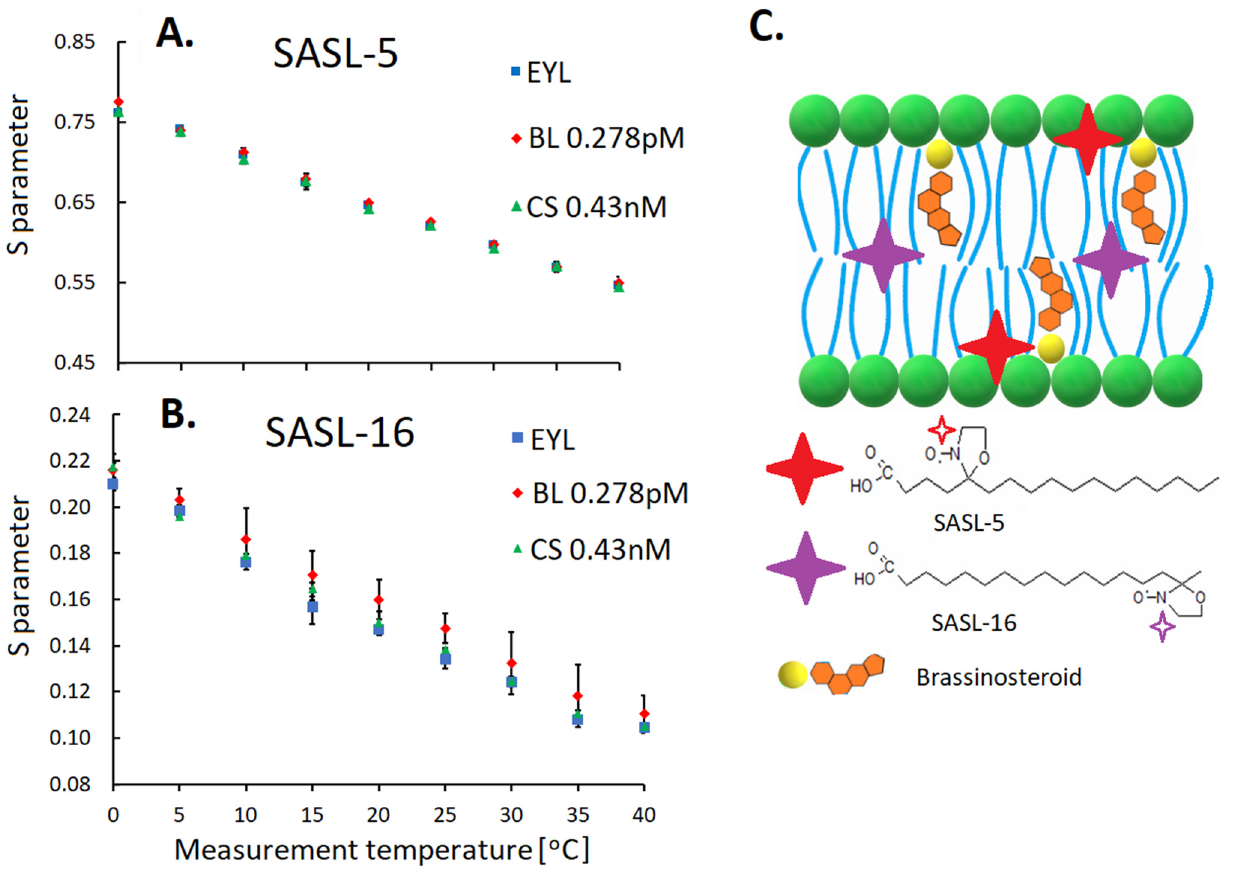
Figure 4. Dependence of the order parameter S of the model membranes that had been prepared from egg yolk lecithin (EYL) with incorporated spin labels SASL-5 ( A ) or SASL-16 ( B ) and BR (BL— brassinolide; CS—castasterone at sample concentrations corresponding to their natural concentrations in chloroplasts) on the measurement temperature of the spectra using the EPR method. ( C ) Model of the prepared model membrane. The liposomes were prepared according to the modified method described earlier in work Sadura [135]. Briefly, spin labels (SASL-5 or SASL-16) (0.1 mM) and BR (BL or CS) (at a certain concentration) were added to EYL (10 mM). Next, it was shaken on a